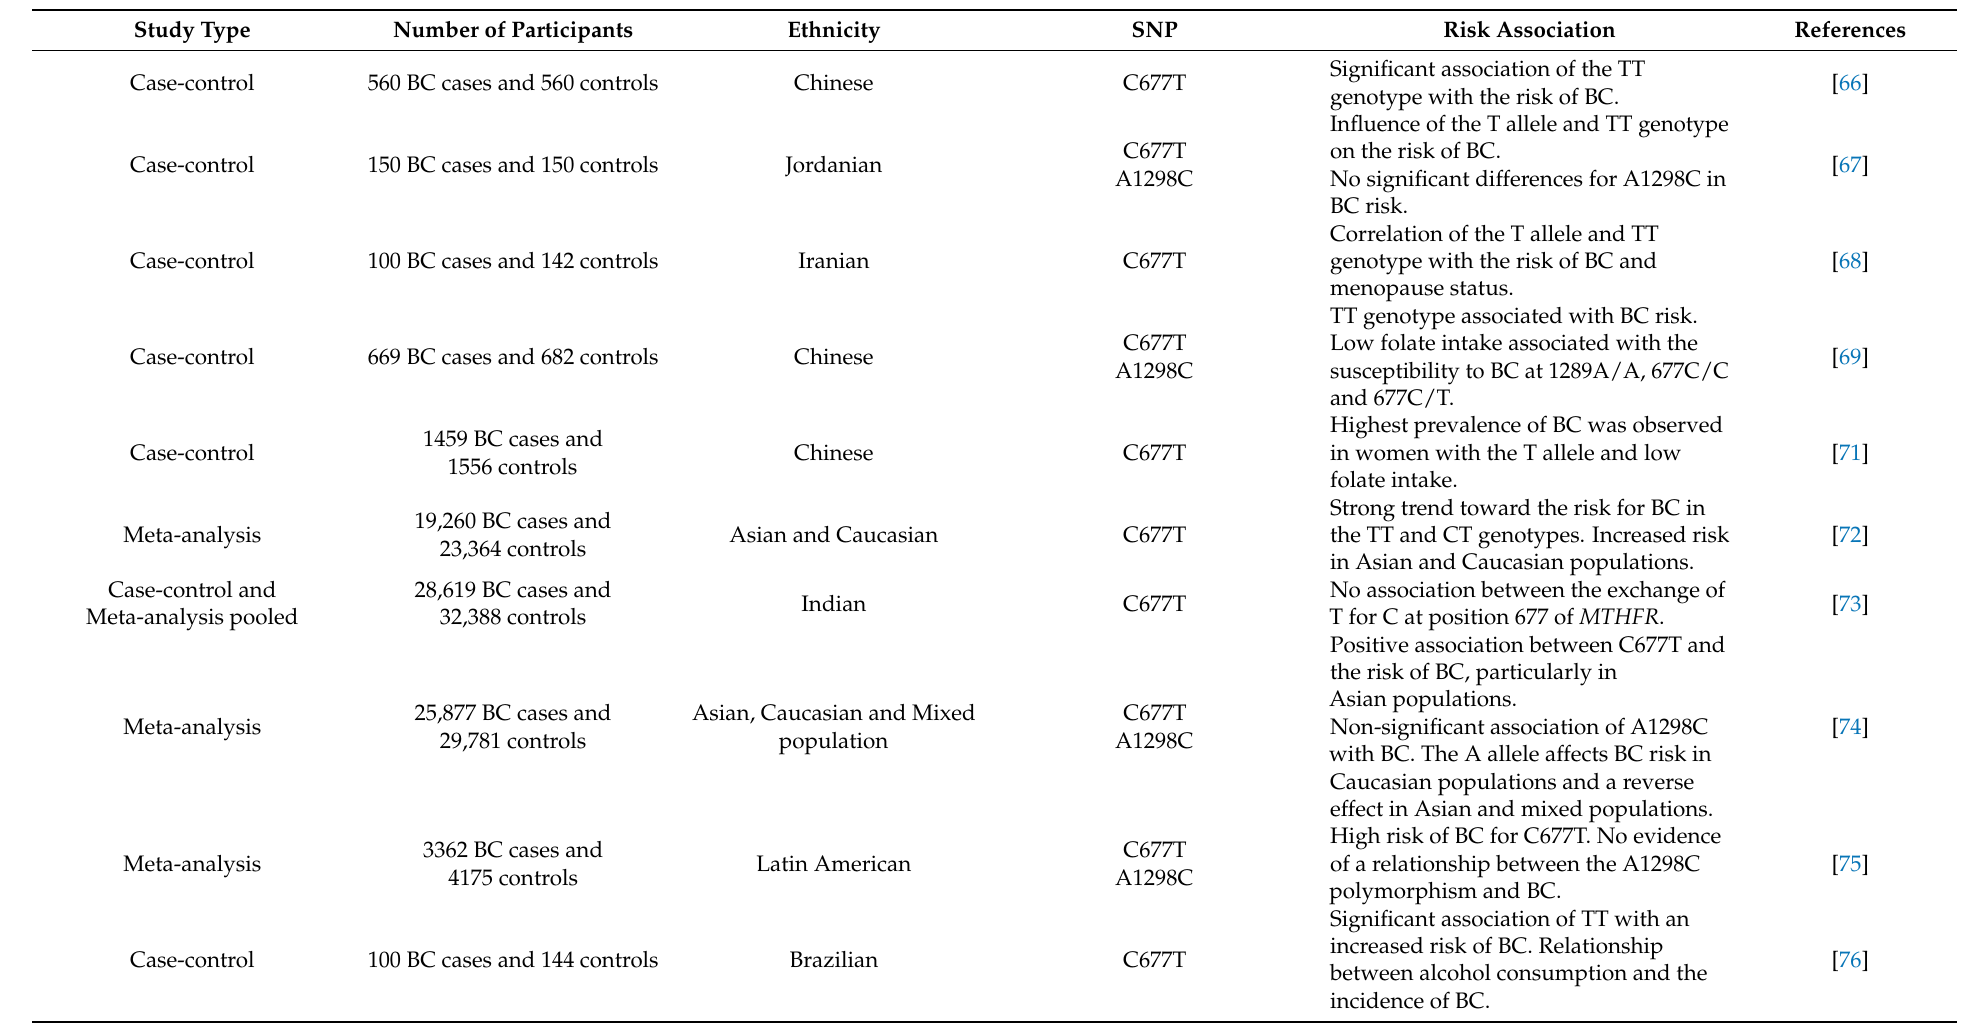
Table 1. Effect of the polymorphisms on breast cancer